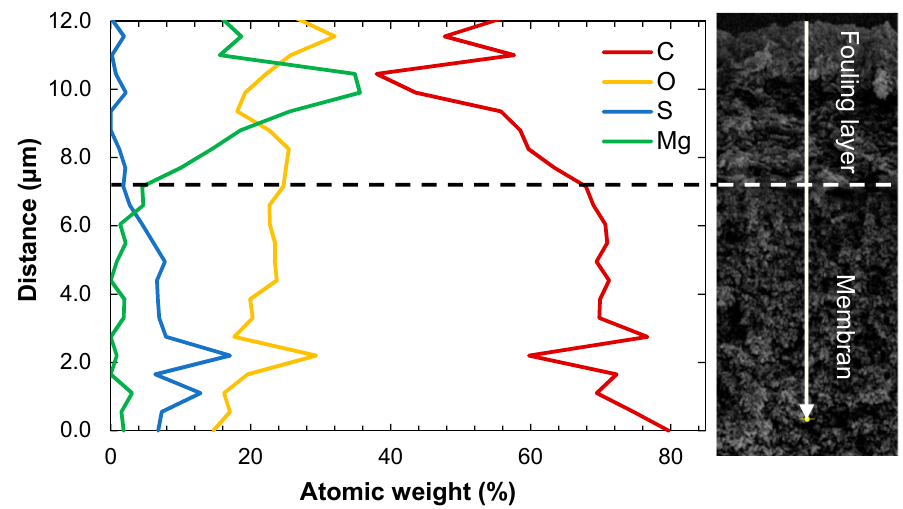
Figure 4. The atomic weight % of different elements in the cross-section along the fouling layer and active layer of the membrane ( left ) and SEM image of the cross-section of the fouling layer and the active layer of the membrane ( right ).